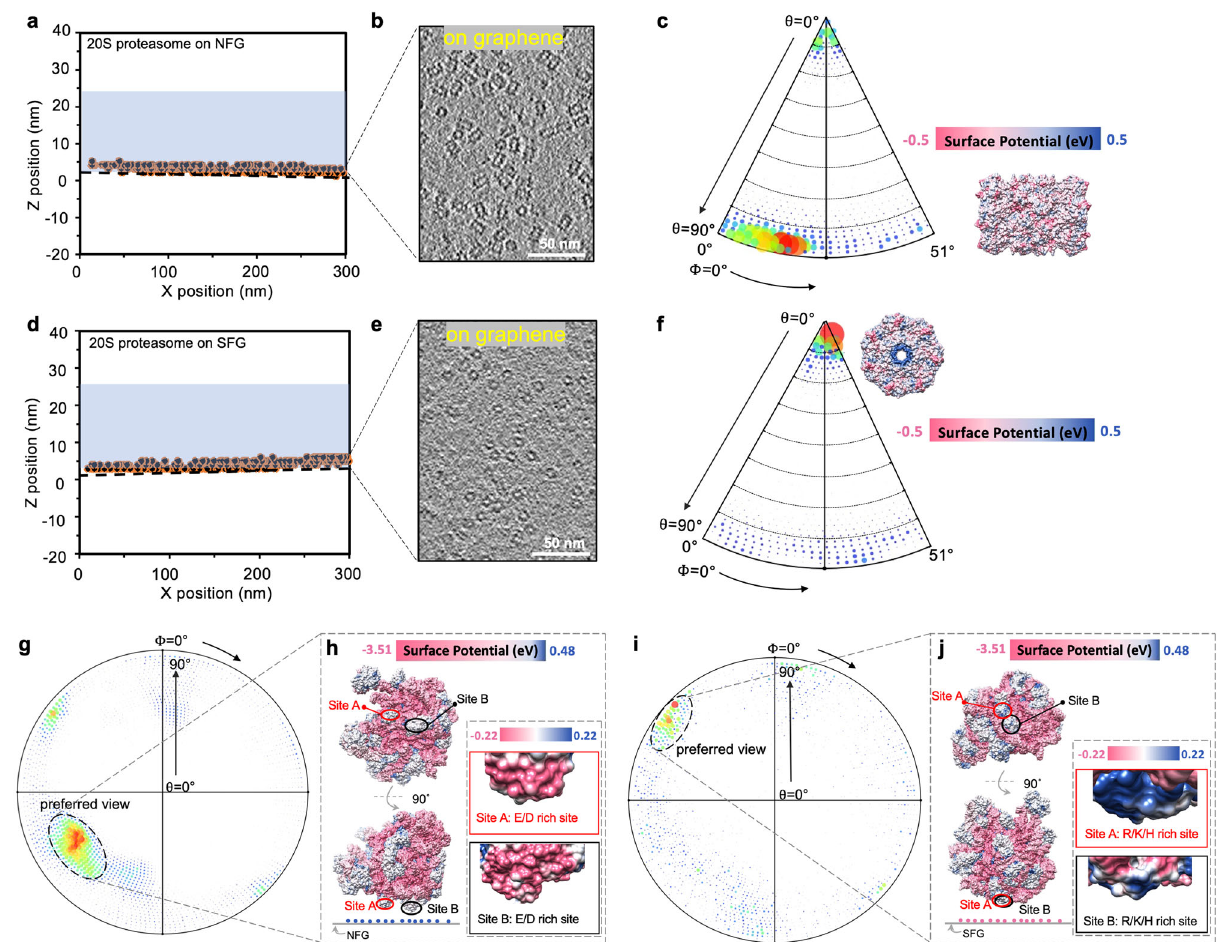
Fig. 3 | Graphene modi fi ed by distinct ligands for cryo-EM analysis. a The dis- tribution of 20S proteasome particles on NFG membrane, revealed by cryo-ET reconstruction. Each spot indicates one individual particle. The black dotted line represents the graphene support. b The graphene surface section extracted from the cryo-tomogram of NFG-supported specimen, where the majority particles aredistributed. c TheEulerangledistributionof20SproteasomeparticlesonNFG. The bigger (redder) the spot, the more particles are in the corresponding orien- tation. The preferred view (side view) is displayed aside, with its map surface coloredbyelectricpotential. d Thedistributionof20SproteasomeparticlesonSFG membrane, revealed by cryo-ET reconstruction. e The graphene surface section extracted from the cryo-tomogram of SFG-supported specimen, where the